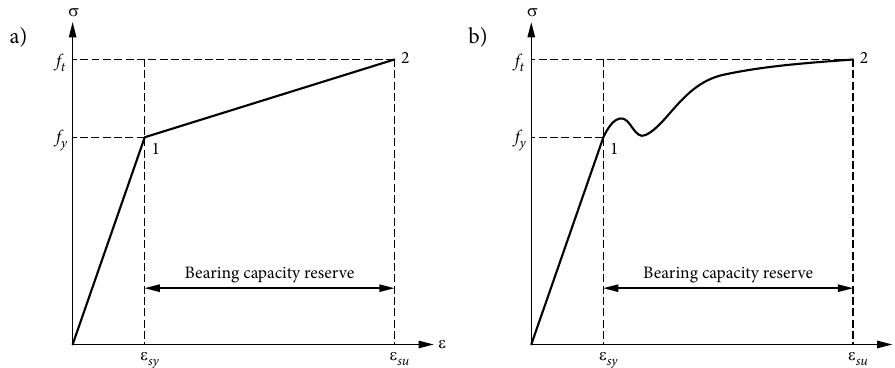
Fig. 1. The examined stage of reinforcement stress: a – bilinear hardening material model; b – steel stress-strain curve (Atkočiūnas, Čižas